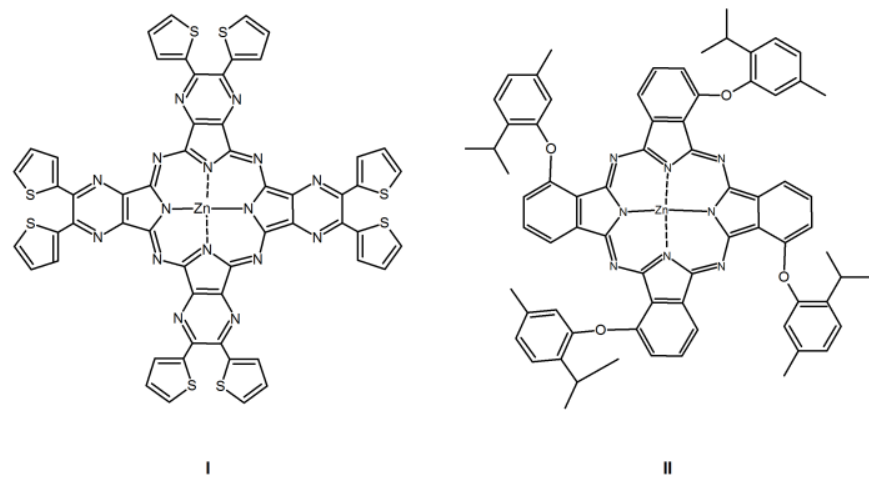
Figure 6. Chemical structures of macrocycles I - II .